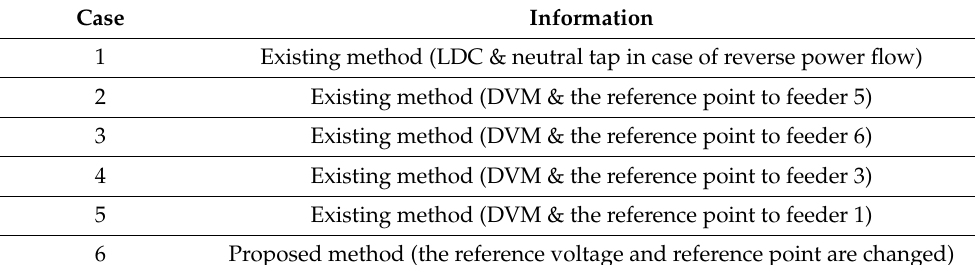
Table 3. Case studies